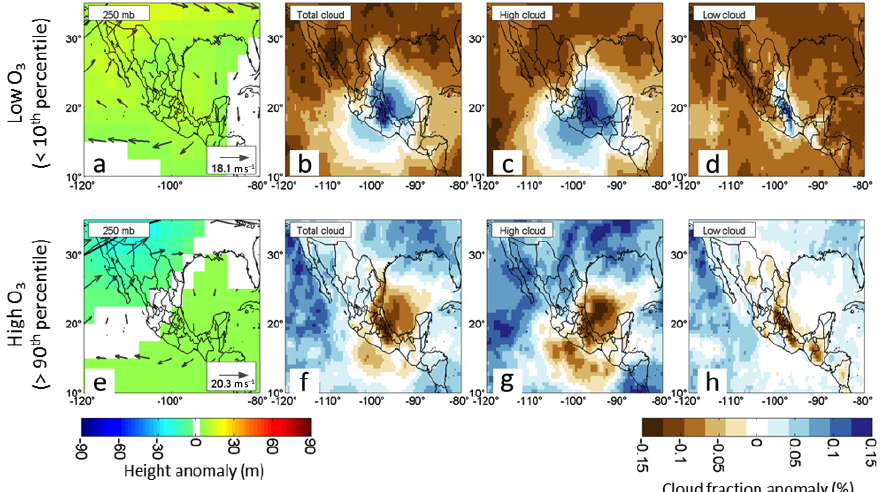
Figure 6. As in Fig. 5, but for summer (JJA)